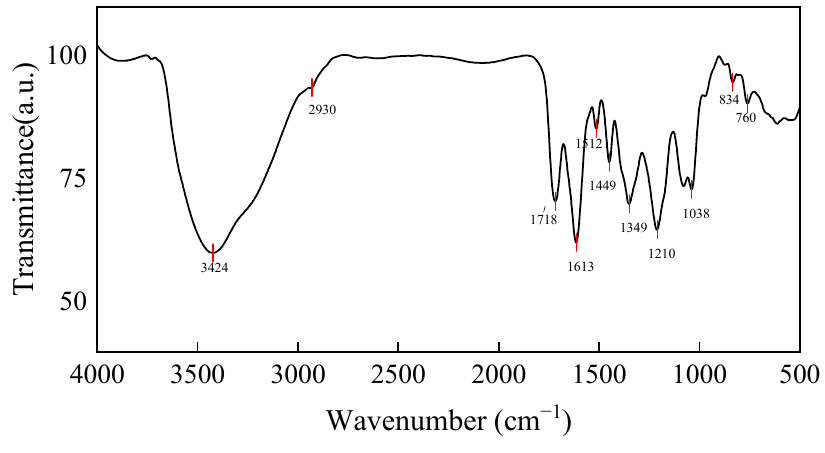
Figure 6. FTIR-NHEP illustrating structural features.